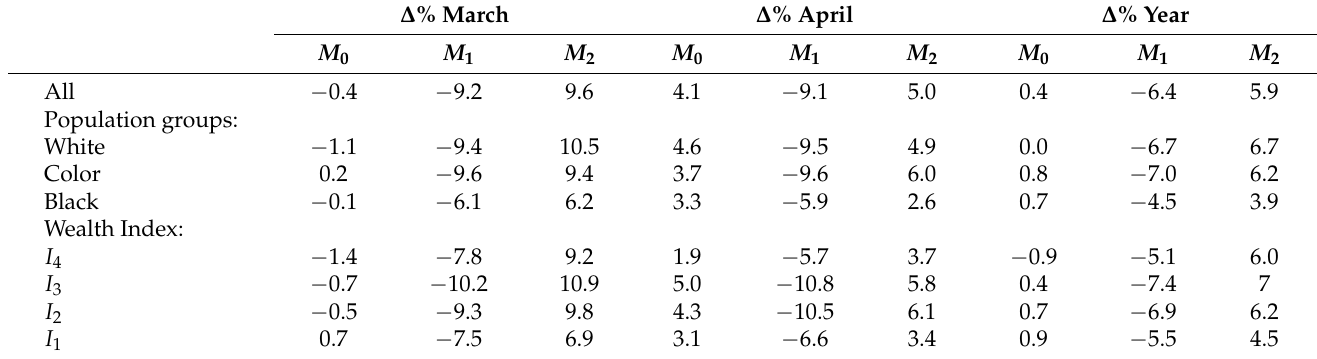
Table 2. Table of the percentage change from the control to lockdown period in the number of meters with purchases within M 0 , M 1 , and M 2 for March, April, and for the whole year. The rows represent a further separation of the results into the corresponding population groups and wealth indicators of the